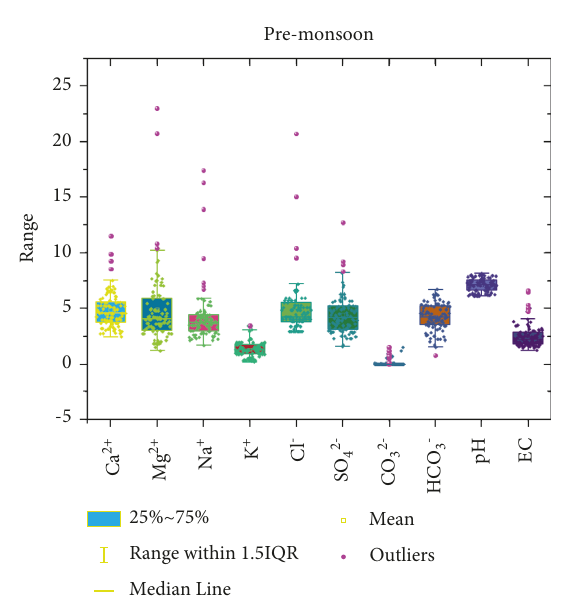
Figure 3: Box–Whisker plot of premonsoon season. Figure 4: Box–Whisker plot of postmonsoon